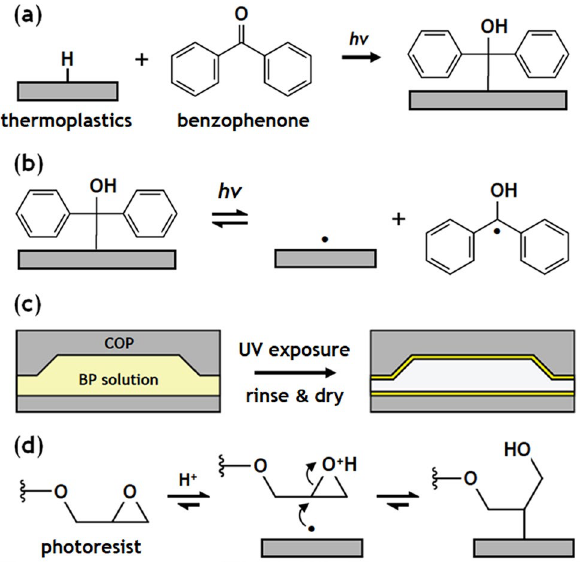
Figure 2. Chemical modification of thermoplastic surface using BP. ( a ) BP is converted into a semi- benzopinacol or its radical derivatives under UV irradiation, and reacts with thermoplastic polymer which serves as a proton donor. ( b ) The BP-treated thermoplastic surface may then be photoactivated for covalent bond formation between the surface and an exogenous material upon UV irradiation. ( c ) A COP microchannel filled with BP solution, and exposed to UV, rinsed, and dried, yielding a photoactive surface before introducing a photoresist in preparation for DLW. ( d ) Covalent bond formation scenario for the epoxy-based resin. When the laser path coincides with the microchannel surface, free radicals are formed on the COP surface that immediately react with the epoxide ring of the resin, yielding a covalent bond between the resin and thermoplastic